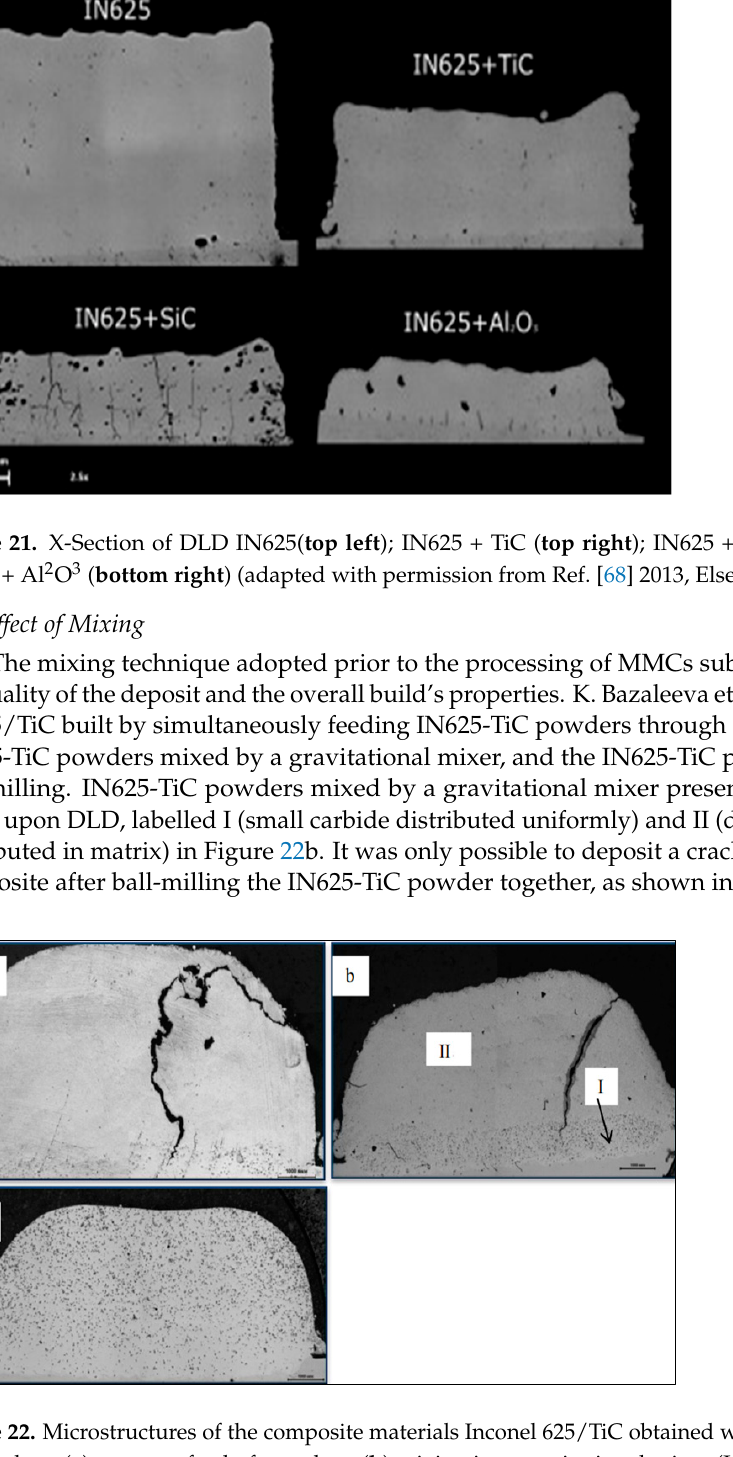
Figure 21. X-Section of DLD IN625( top left ); IN625 + TiC ( top right ); IN625 + SiC ( bo tt om left ); IN625 + Al 2 O 3 ( bo tt om right ) (adapted with permission from Ref. [68] 2013, Elsevier).